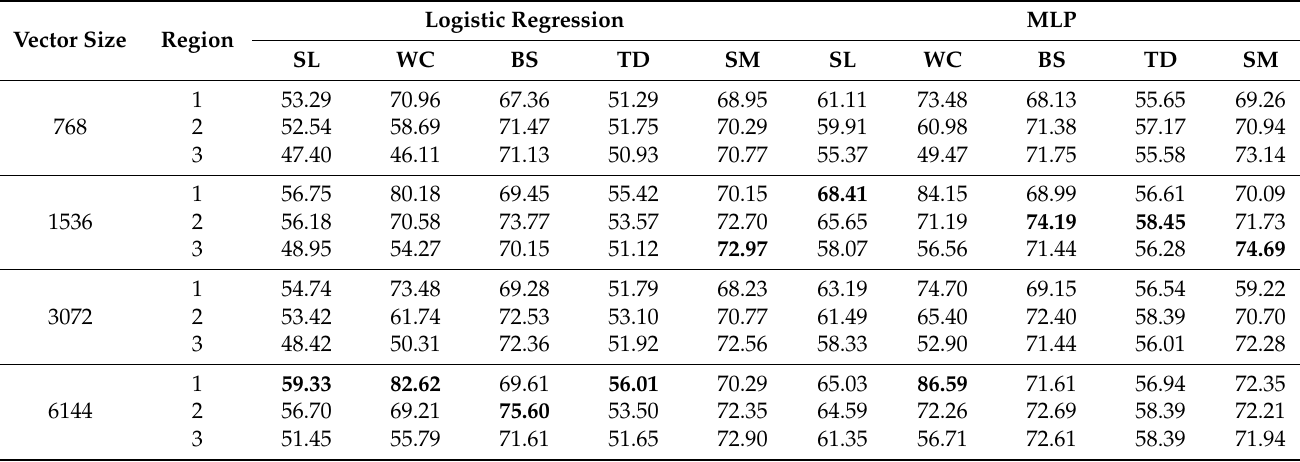
Table 8. Average classification accuracy for different sentence vector sizes derived with four hidden layers using different pooling strategies.